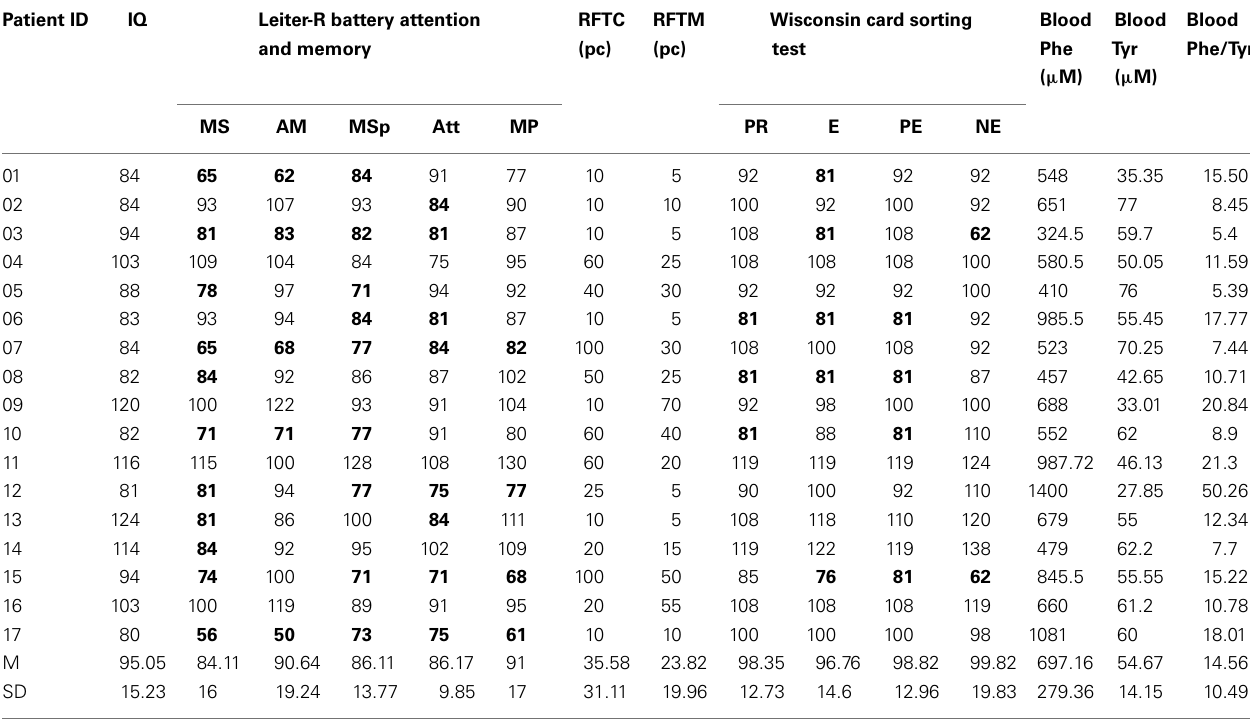
Table 3 | Results of neurocognitive tests and concomitant biochemical values